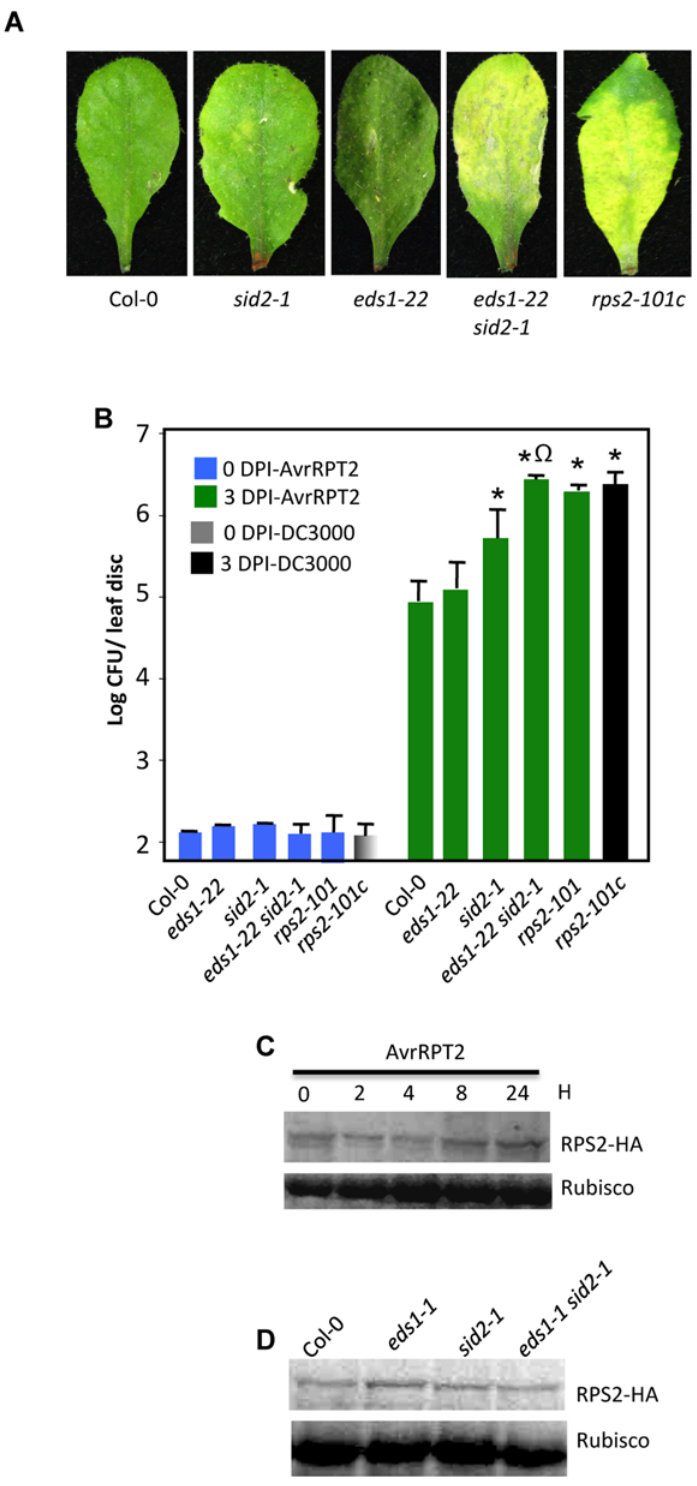
Figure 4. Interaction phenotypes of virulent or AvrRPT2 -expressing P.syringae with eds1sid2 plants. (A) Photograph showing phenotypes produced upon infiltration of 10 5 CFU/ml bacteria ( AvrRPT2 ). All genotypes were in the Col-0 background. The leaves were photographed at 3 days post inoculation (dpi). The pathogen-inoculated EDS1 SID2 F2 plants showed absence of any visible symptoms in response to bacterial inoculations, similar to Col-0 plants (data not shown). (B) Growth of virulent or avirulent (expressing AvrRPT2 ) P. syrinage on indicated genotypes. The error bars indicate SD. Asterisks and omega symbols indicate data statistically significant from wt (Col-0) or sid2 (P , 0.05, n=4), respectively. All genotypes are in the Col-0 background. (C) Levels of HA-tagged RPS2 protein at 0, 2, 4, 8, and 24 h post inoculation with P. syringae expressing AvrRPT2 . Levels of Rubisco were used as the loading control. (D) Levels of HA-tagged RPS2 protein in indicated genotypes. Levels of Rubisco were used as the loading control.